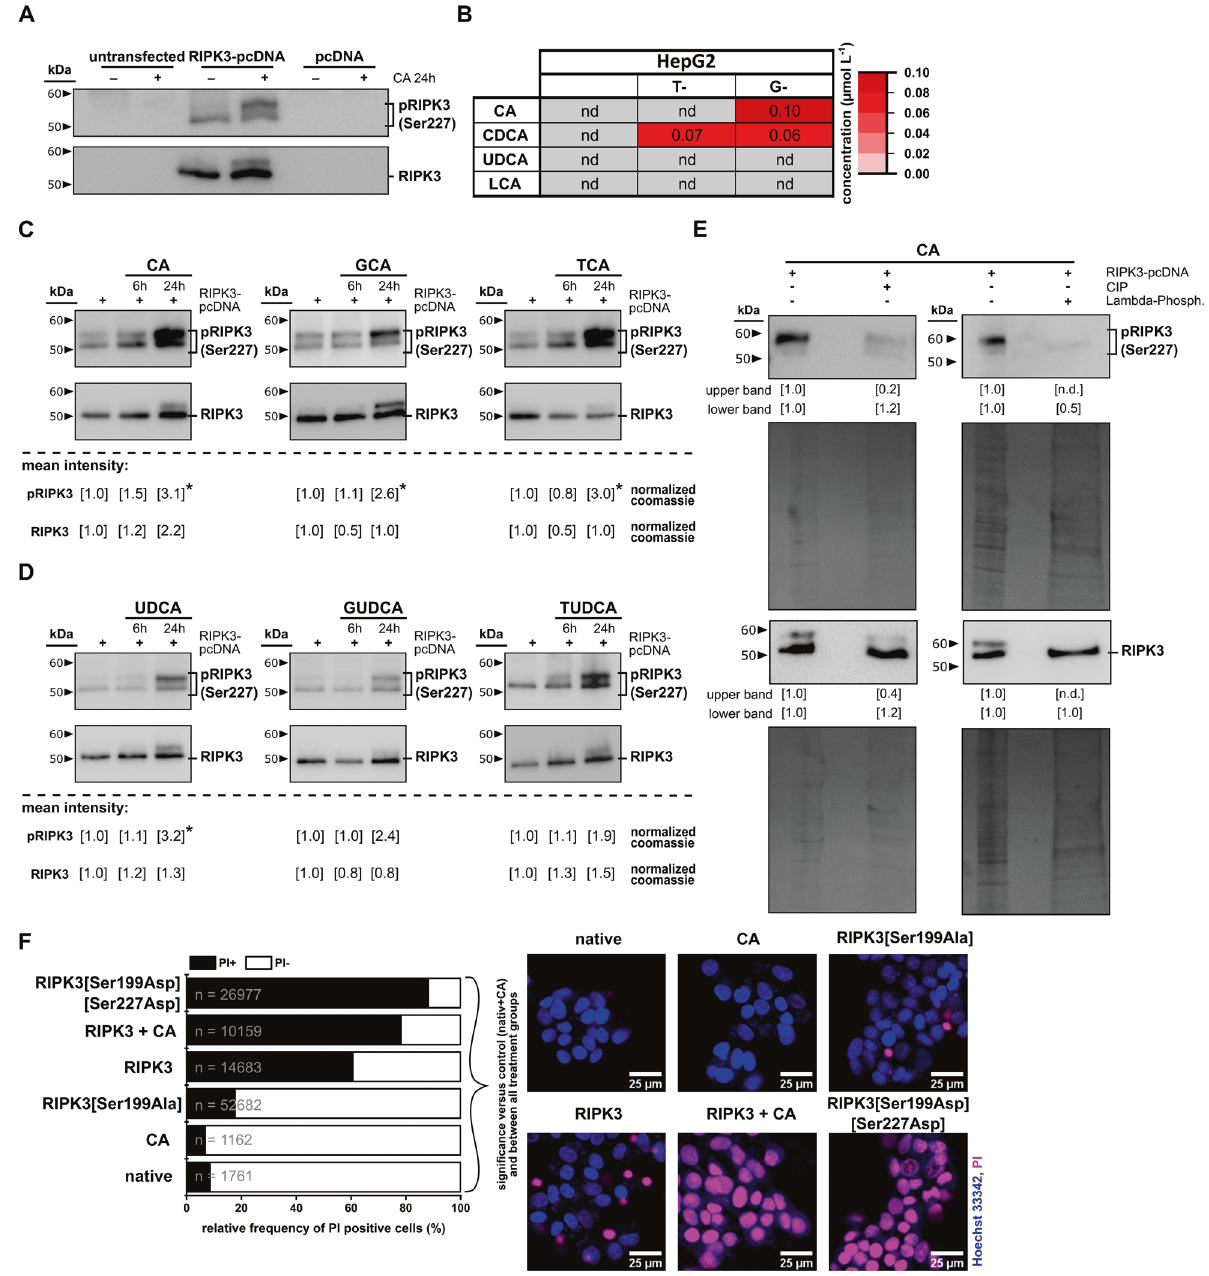
Fig. 3 Bile acids can affect RIPK3 activation. A A representative blot of RIPK3 expression and phosphorylation after transfection of the hepatocellular carcinoma cell line (HepG2) with a pcDNA plasmid and RIPK3-pcDNA plasmid for 24 h. B Amount of bile acids in HepG2 cells detected by LC – MS/MS. The analysis was performed on 3 individual samples. Gray-colored values were not detected (nd). C , D RIPK3 phosphorylation and expression in HepG2 cells upon stimulation with different endogenous bile acids (50 µmol L − 1 ) for 6 h or 24 h. Stimulation with un-, taurine (T)- or glycine (G)-conjugated C cholic acid (CA) and D ursodeoxycholic acid (UDCA). C , D Coomassie staining of SDS-PAGE gel was used as a loading control. n = 3 – 4. C * p < 0.05 vs. control, RIPK3: one-way ANOVA; pRIPK3: one-way ANOVA with post-hoc Dunnett ’ s test. D * p < 0.05 vs. control, RIPK3: UDCA with one-way ANOVA, TUDCA/ GUDCA with Kruskal – Wallis test; pRIPK3: UDCA with one- way ANOVA with post-hoc Dunnett ’ s test, TUDCA/ GUDCA with Kruskal – Wallis test. E RIPK3-pcDNA transfected HepG2 cells are lysed and treated with calf intestinal phosphatase (CIP) for 30 min at 37 °C or Lambda phosphatase for 30 min at 30 °C (400 U) before western blot analysis of RIPK3 expression and phosphorylation. The upper lane was not detected (nd) in the treated samples. Coomassie-stained gels were used as loading controls. F HepG2 cells were transfection with RIPK3/ RIPK3 mutants (24 h) and stimulation with cholic acid (CA) (24 h; 50 µmol L − 1 ). The frequency bar depicts the percentage of PI-positive (magenta) dead cells. Representative micrographs are on the right side. Cells were counterstained with Hoechst 33342 (blue). The numbers of analyzed cells in three experiments (n) for each condition are provided in the bar plot. Z-test with Bonferroni adjusted p value. The p values of treatment groups versus control and among each other were smaller than 0.005. Statistics: Figure Data, additional statistical information, and p values are provided in Supplementary Materials 2 and 3.